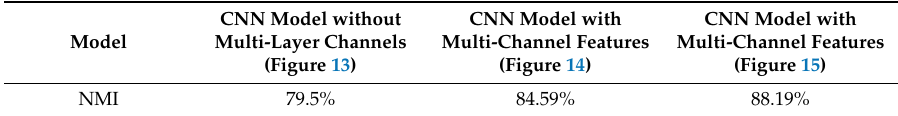
Table 1. Normalized Mutual Information (NMI) Scores obtained for the input features for the various deep-learning models used (for the test data sets used in this work).